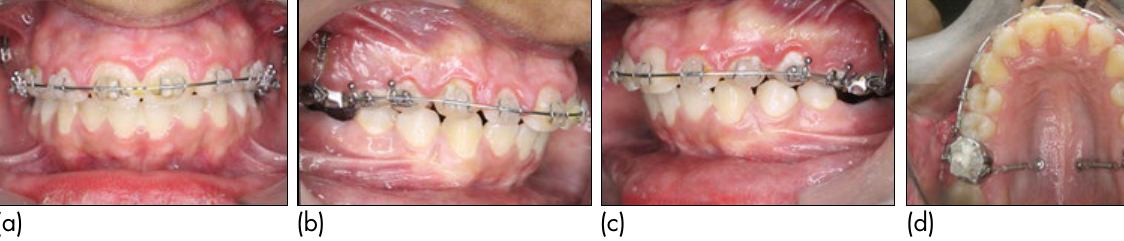
Figure 5 (a, b, c, d). Buccal and palatal miniscrews loaded with NiTi closed coil springs.